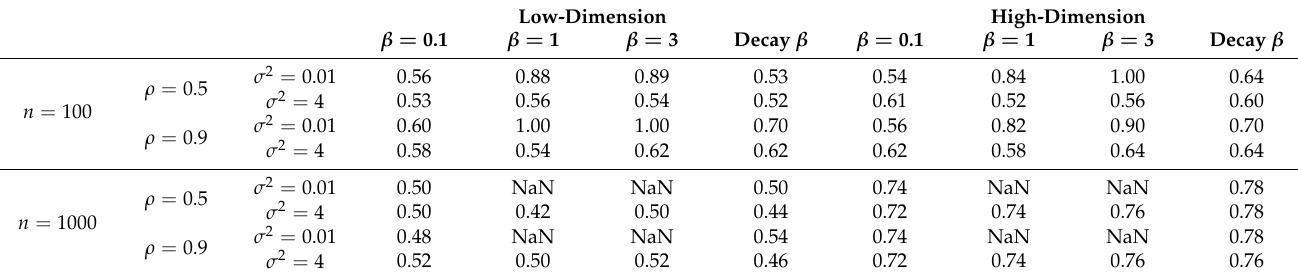
Table A6. Regression estimation: probability of λ min doing better, constant correlation. Low-Dimension